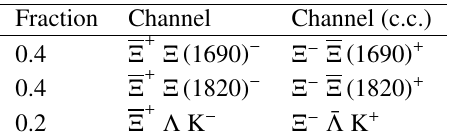
Table 2. Decay modes and ratios used as input for the event